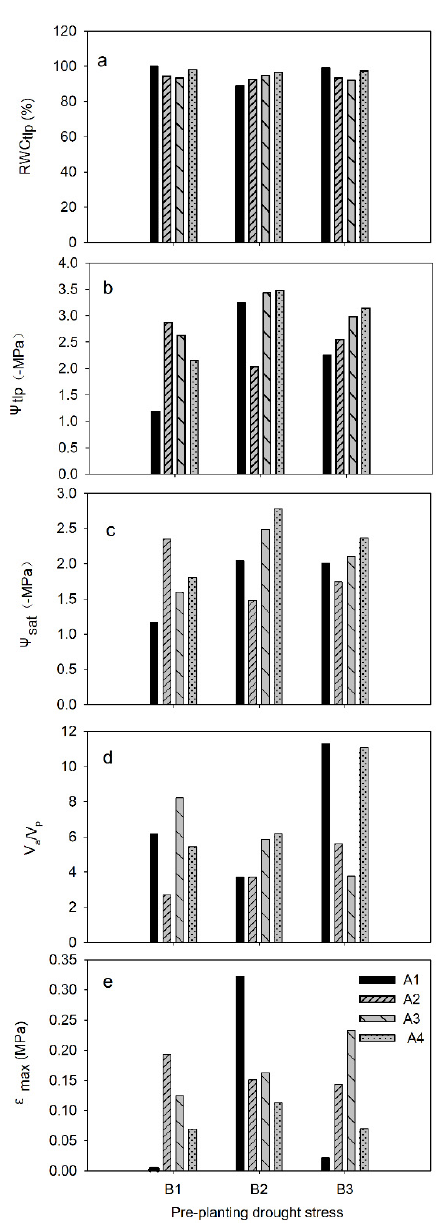
Figure 4. Relative water content at the turgor-loss point (RWC tlp ) ( a ), initial osmotic potential at the turgor-loss point ( ψ tlp ) ( b ), saturation water osmotic potential ( ψ sat ) ( c ), ratio of bound-water content to free-water content (V a /V p ) ( d ), and the cell maximum bulk modulus of elasticity ( ε max ) ( e ) of shoots in lacebark pine seedlings by four weeks of post-planting drought treatments (A1, A2, A3, and A4). A1, 75%–80% soil relative water content (SRWC); A2, 55%–60% SRWC; A3, 35%–40% SRWC; and A4, 15%–20% SRWC. B1, adequate irrigation before planting; B2, 5 days of drought before planting; and B3, 10 days of drought before planting.